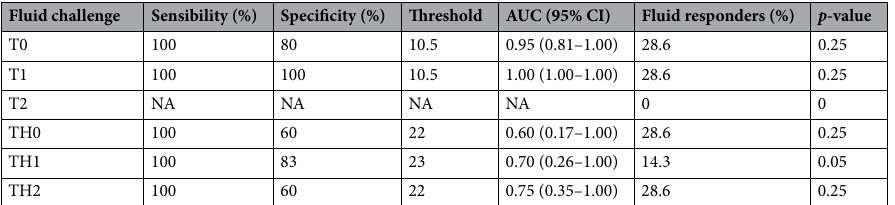
Table 2. Operative performance of PPV in each fluid responsiveness. AUC , area under curve. T0, baseline in both groups; T1, 1 h after T0; T2, 2 h after T0; TH0, when an MAP < 50 mm Hg was reached. In the control group, this time was set at 3 h of observation. TH1, 1 h after TH0; TH2, 2 h after TH0. p -value represents the difference between fluid responders and non-fluid